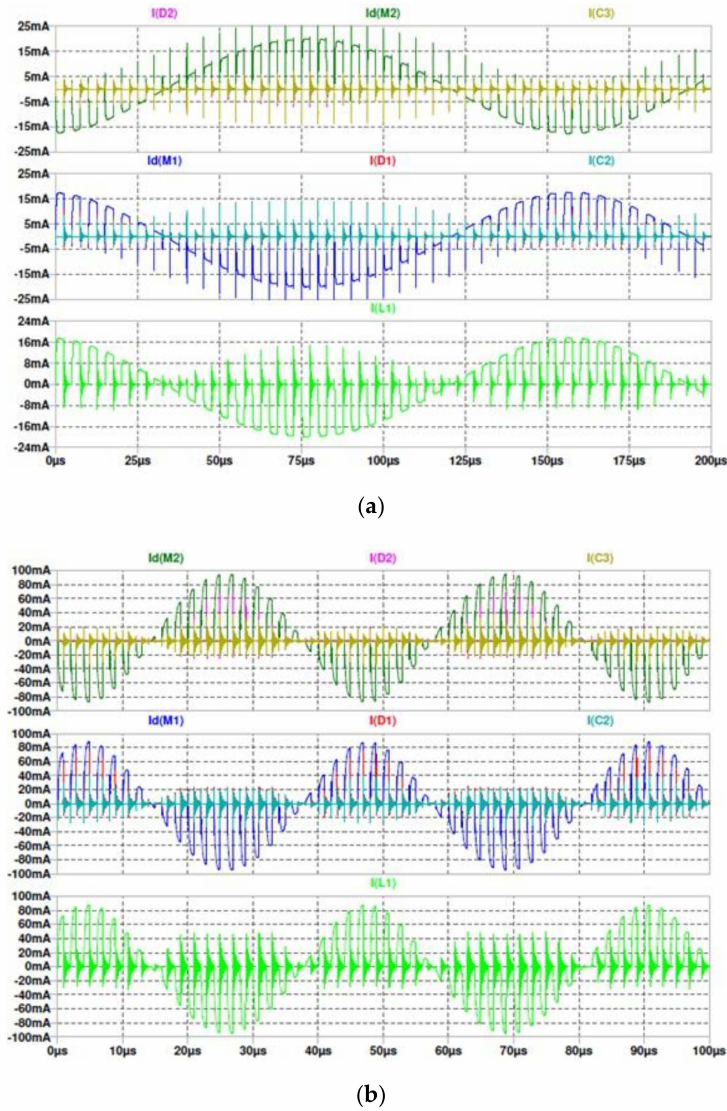
Figure 28. Circuit internal signals inside the architecture. ( a ) A 3 m / s wind velocity. ( b ) A 10 m / s wind